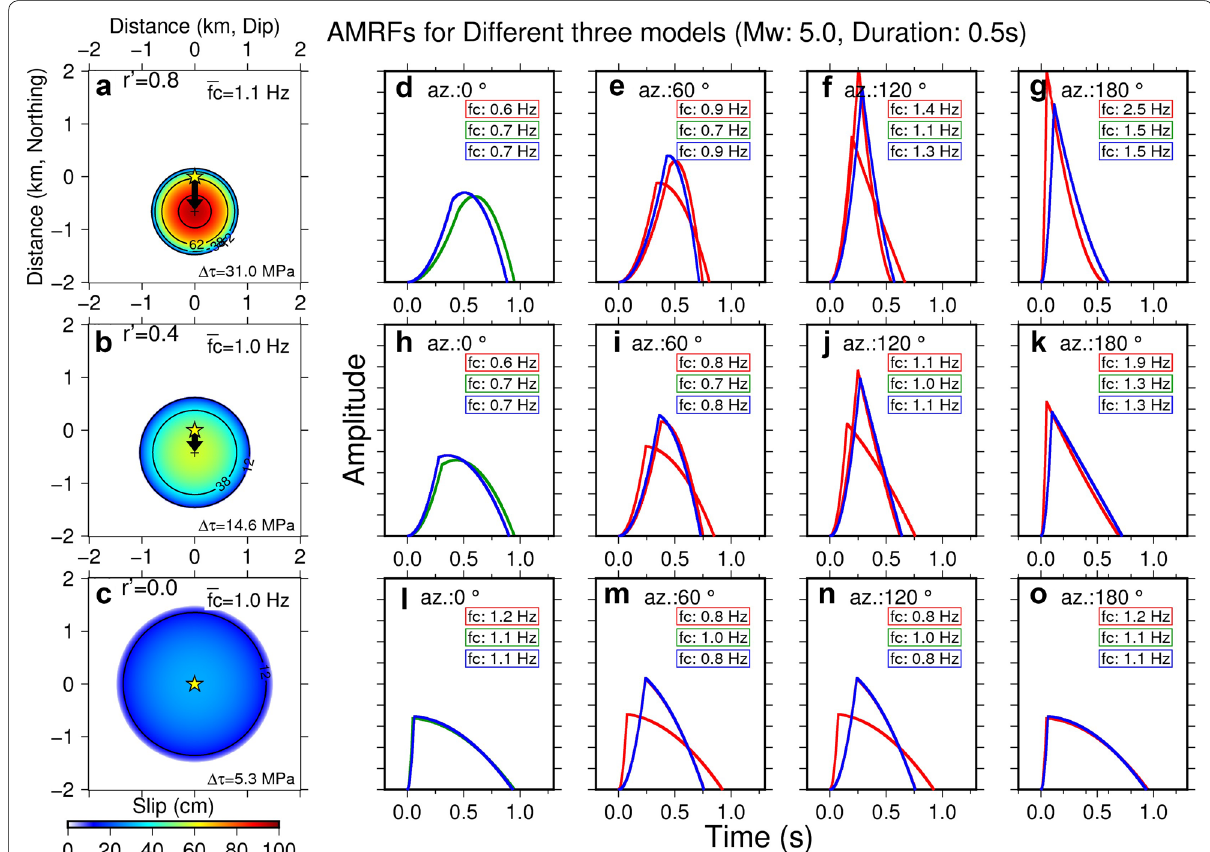
Fig. 2 Examples of a – c coseismic slip models and d – o computed theoretical moment rate functions. The three ruptures have the same source durations (0.5 s) and moment magnitudes (5.0). Red, green, and blue curves in d – o show the results at takeoff angles of 45°, 90°, and 135°,